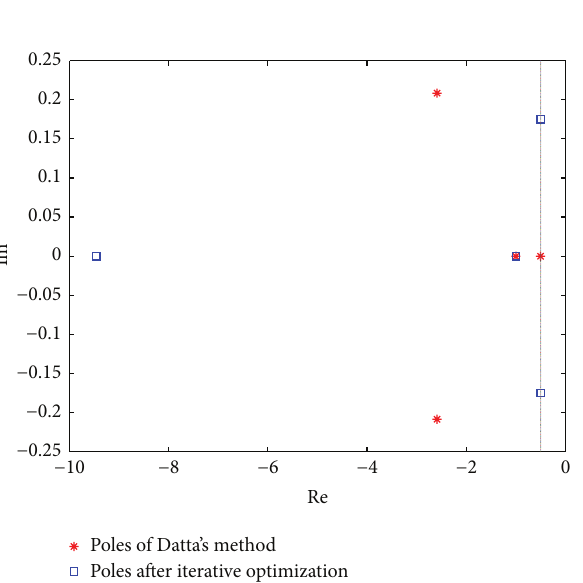
Figure 2: Closed loop poles of Example